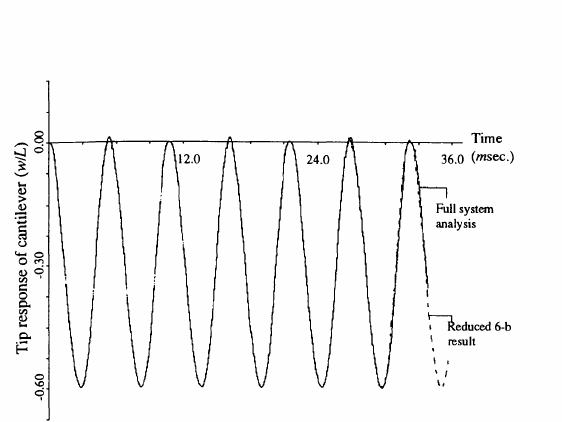
FIGURE 5 Cantilever under step load. Comparison of tip response between full system and reduced 6- basis nonlinear analysis.